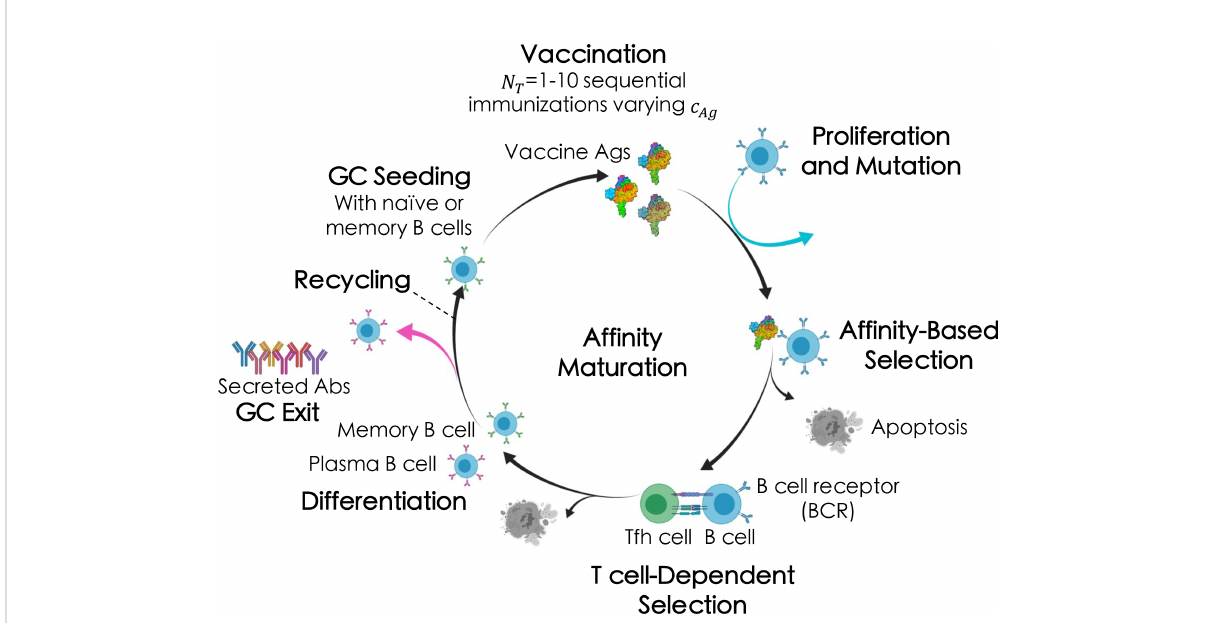
FIGURE 2 Broad overview of the af fi nity maturation (AM) process by which antibodies (Abs) evolve against vaccine-candidate antigens (Ags) in a germinal center (GC) reaction (see text for details). Here, we administered between one and ten total immunizations, N T , of a single Ag, varying only the Ag concentration, c Ag , in each immunization (indicated by the different shades of the